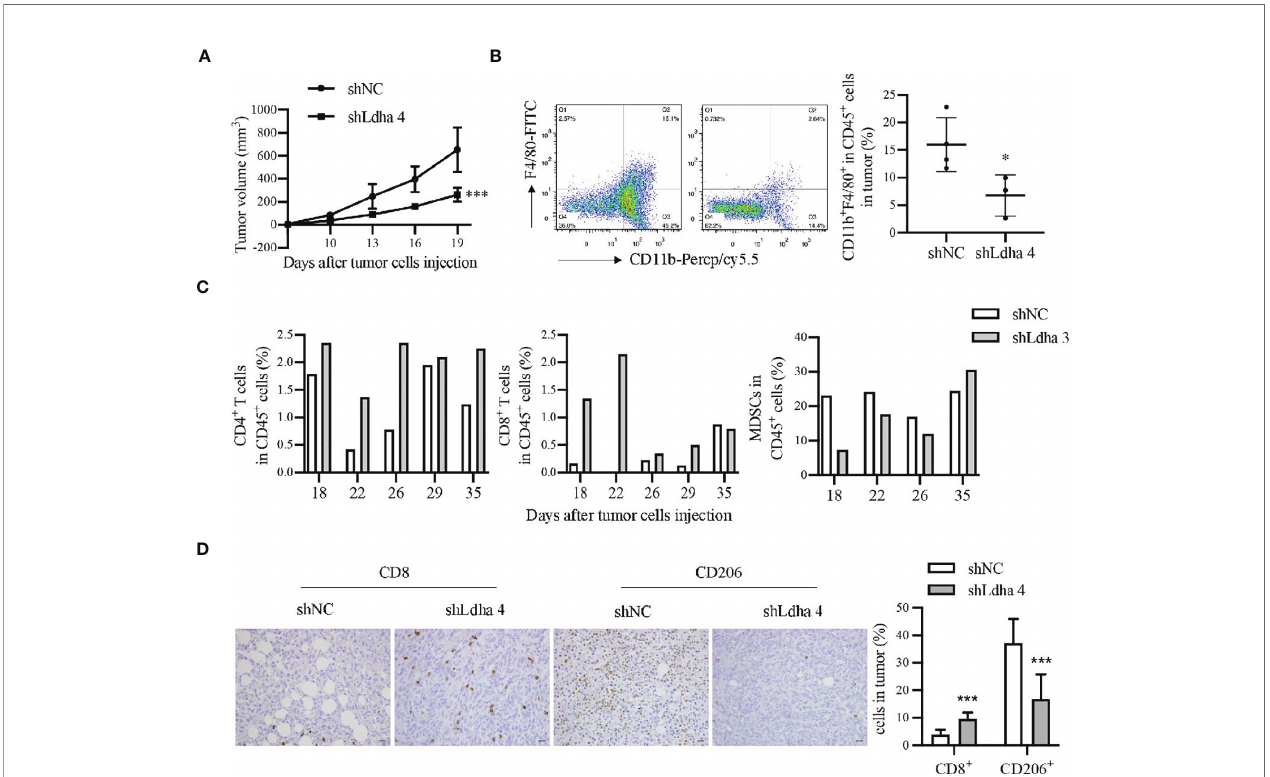
FIGURE 5 | LDHA promoted tumoral in fi ltration of TAMs in 4T1 murine breast cancer model. (A) Tumor growth curve of mice inoculated with 4T1-shNC or 4T1- shLdha cells. 1×10 5 cells per mice were injected into the fourth breast fat pad of Balb/c mice (n = 9 in 4T1-shNC group, n = 7 in 4T1 shLdha group). (B) Percentage of CD11b + F4/80 + macrophages in CD45 + immune cells were analyzed by fl ow cytometry. Tumor were harvested on day 19 after the tumor cells injection. CD45-PE, CD11b-Percp/cy5.5 and F4/80-FITC were used to mark macrophages in tumor. (C) Percentage of CD3 + CD8 + T cells, CD3 + CD4 + T cells or CD11b + Gr1 + MDSCs in CD45 + immune cells were analyzed by fl ow cytometry. Tumor were harvested on different days after the tumor cells injection (n = 1 in each group). CD45-PE, CD3 ϵ - FITC, CD4-APC and CD8 a -APC were used to mark T cells in tumor. CD11b-FITC and Gr1-APC were used to mark MDSCs in tumor. (D) The expression of CD8 and CD206 was analyzed by immunohistochemistry in 4T1 shNC or shLdha-injected tumors (n = 9 in 4T1-shNC group, n = 7 in 4T1 shLdha group). Scale bar, 20 m m (insets). * P < 0.05; *** P <